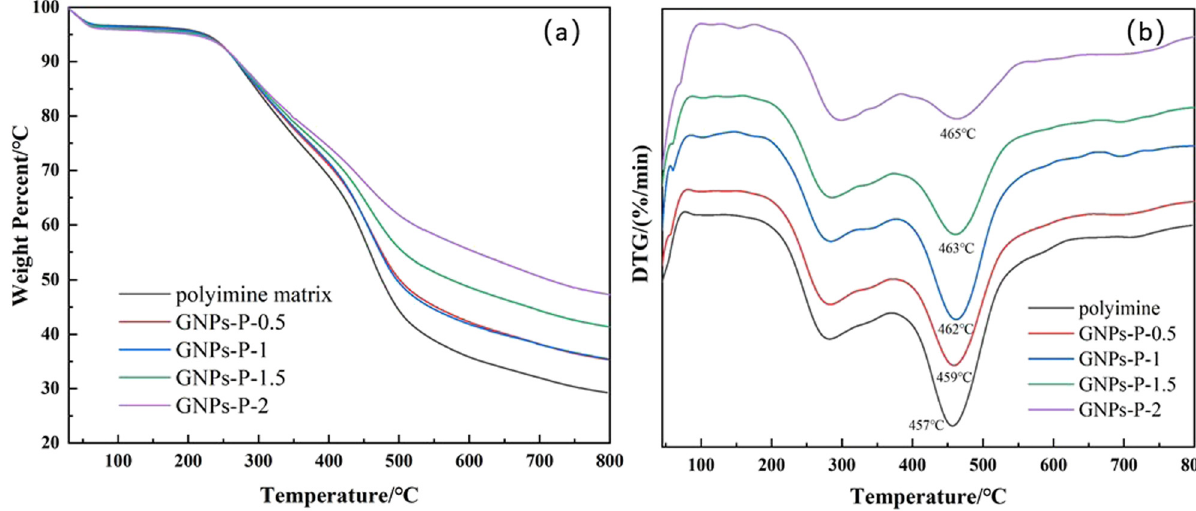
Figure 3: ( a ) TGA curves and ( b ) DTG curves of polyimine and di ff erent GNPs - P composites.